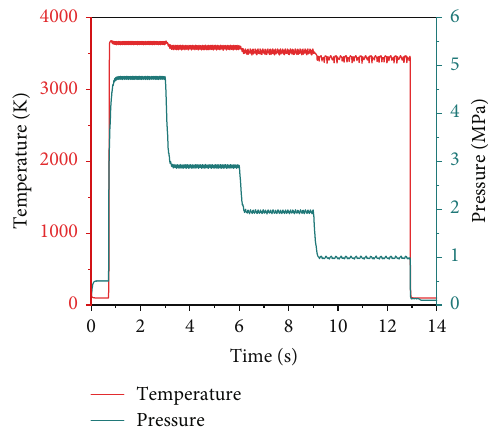
Figure 16: Temperature and pressure changes of the combustion chamber in variable thrust condition.